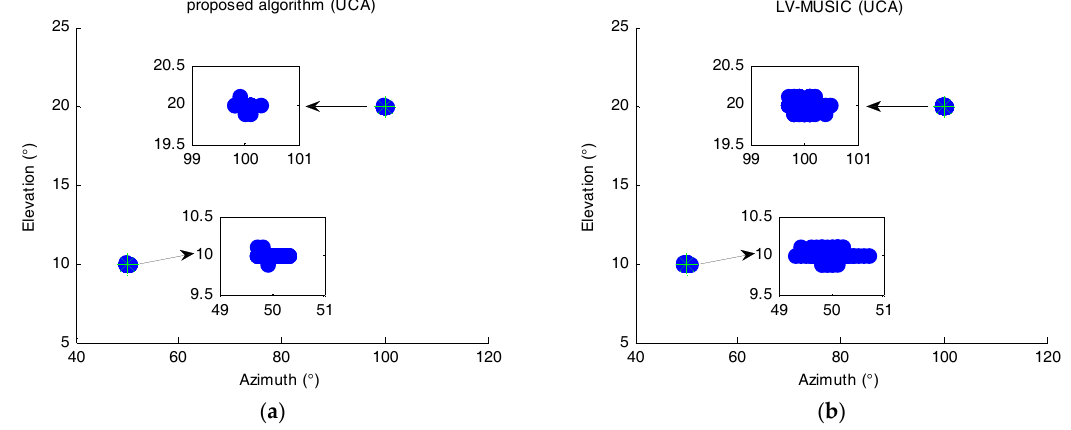
Figure 4. Scatter plots of 2D DOA estimation for ( a ) the proposed algorithm and ( b ) 2D LV-MUSIC Figure algorithm.